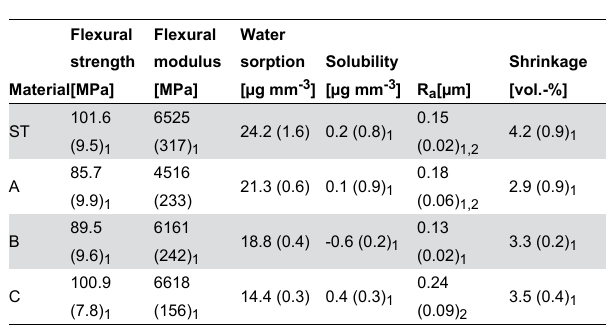
Table 3. Means and (standard deviations) of flexural strength, flexural modulus, water sorption, solubility and surface roughness R , values are rounded to valid digits. a